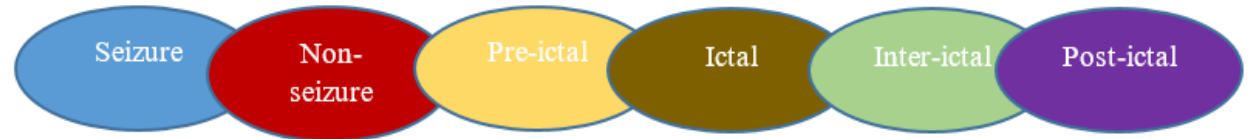
Figure 4. Classification stages in the diagnosis of epileptic seizures.